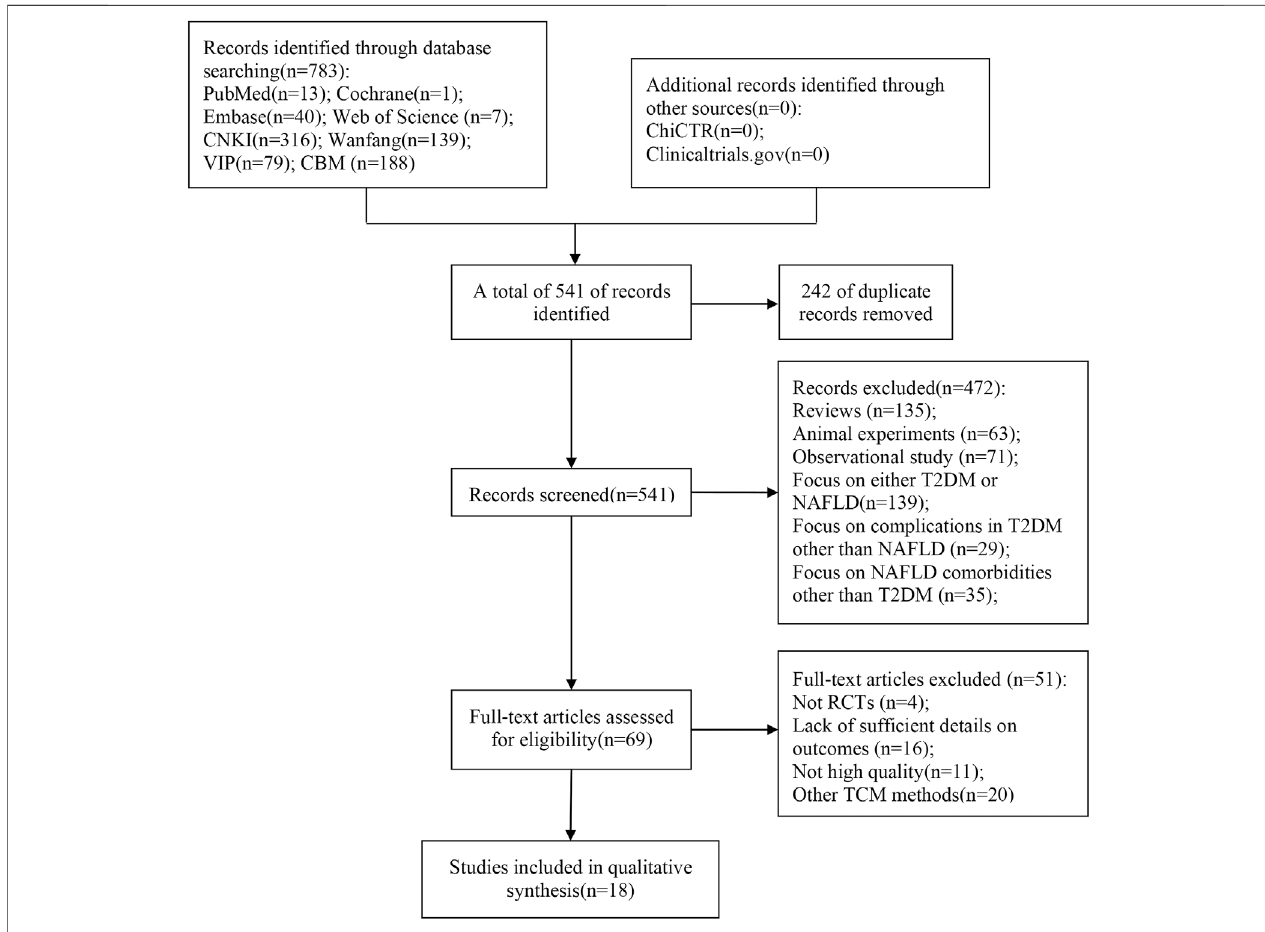
FIGURE 1 | Flow diagram of studies selection